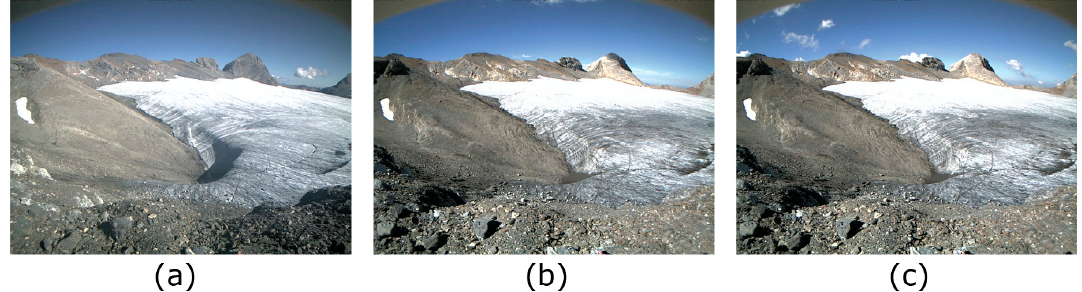
Figure A2. In situ camera images of Glacier de la Plaine Morte on 22 ( a ), 29 ( b ) and 30 ( c ) August 2015. The very bright area in the far back is due to oversaturation of the image. (Image courtesy of Geopraevent AG, Zurich).